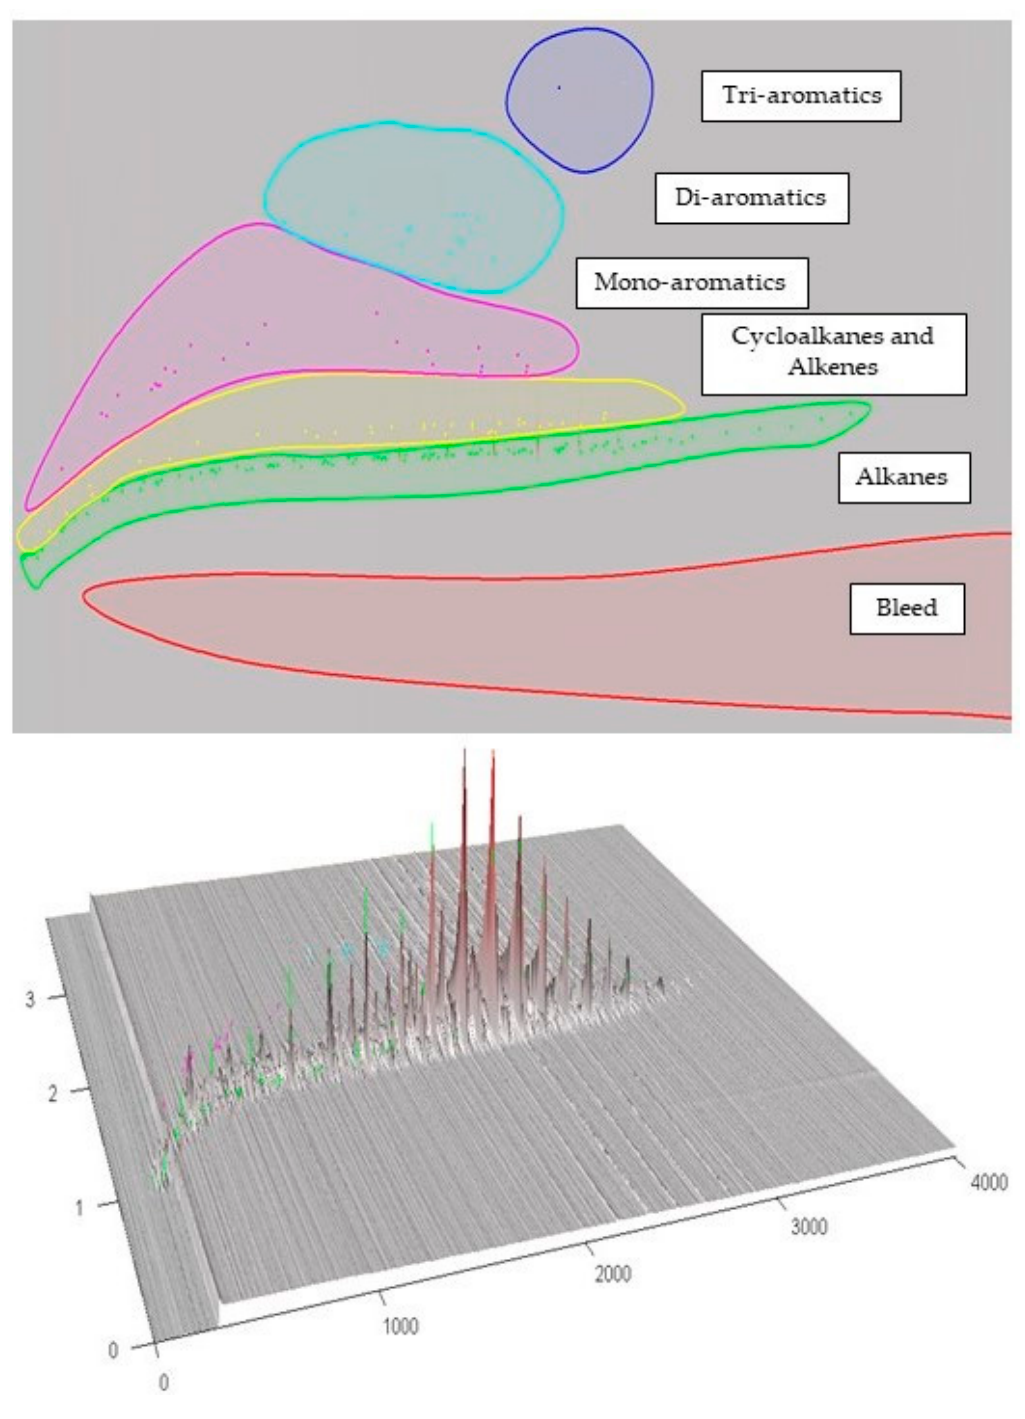
Figure 12. Used feedstock SRGO. The paraffin content was evaluated by simulated distillation (SimDis) (Figures 13–16). The average samples from the second step (after accelerated deactivation) exhibited a slight increase in the contents of pentadecane, hexadecane, heptadecane, and octadecane. In con- trast, the nonadecane content did not change, and the eicosane content slightly decreased (Figure 17). Heptadecane and octadecane exhibited more significant signals than the others. The average sample from the second step (after spontaneous deactivation) in the blank test exhibited a slight increase in the contents of pentadecane and hexadecane. The